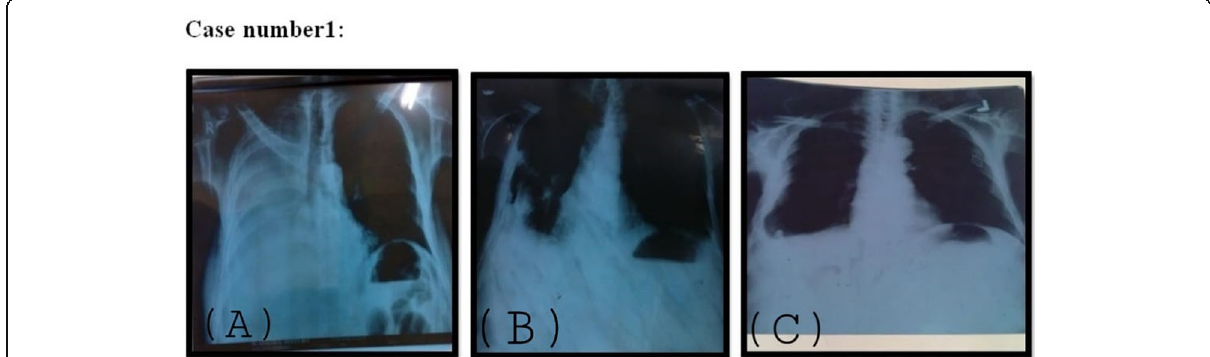
Fig. 1 a Plain chest X-ray PA view showing massive right-sided pleural effusion before drainage. b Plain chest X-ray PA view showing evacuation of the effusion with the pigtail pleural catheter seen in place. c Plain chest X-ray PA view showing complete evacuation of the effusion after pleurodesis by iodopovidone (case 1)